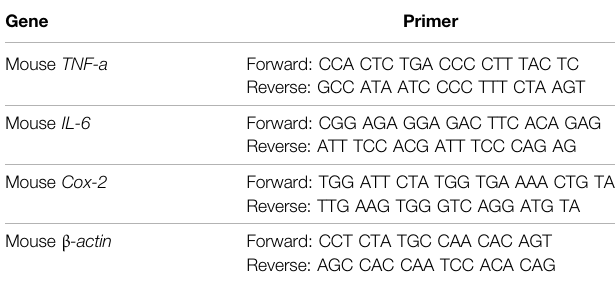
TABLE 1 | Primers used in this study. Gene Primer Mouse